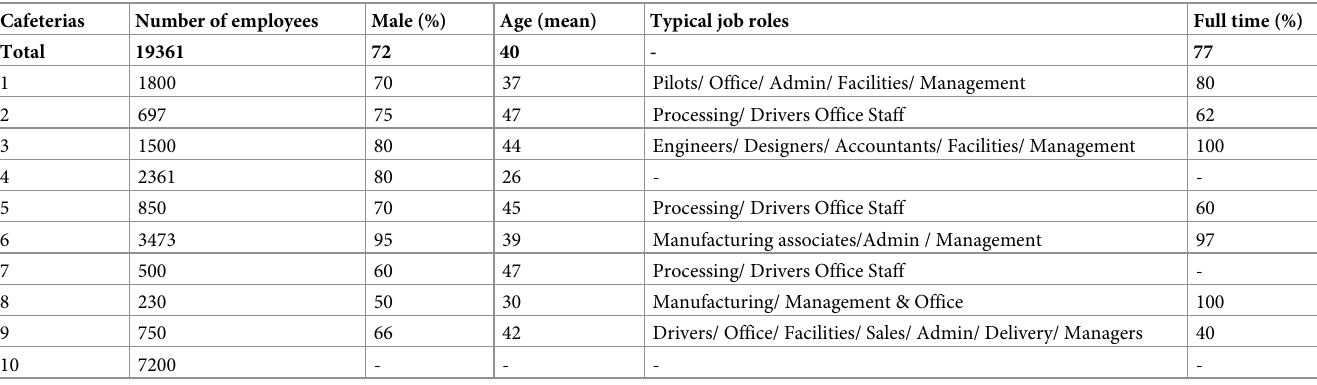
Table 1. Demographic characteristics of employees in participating